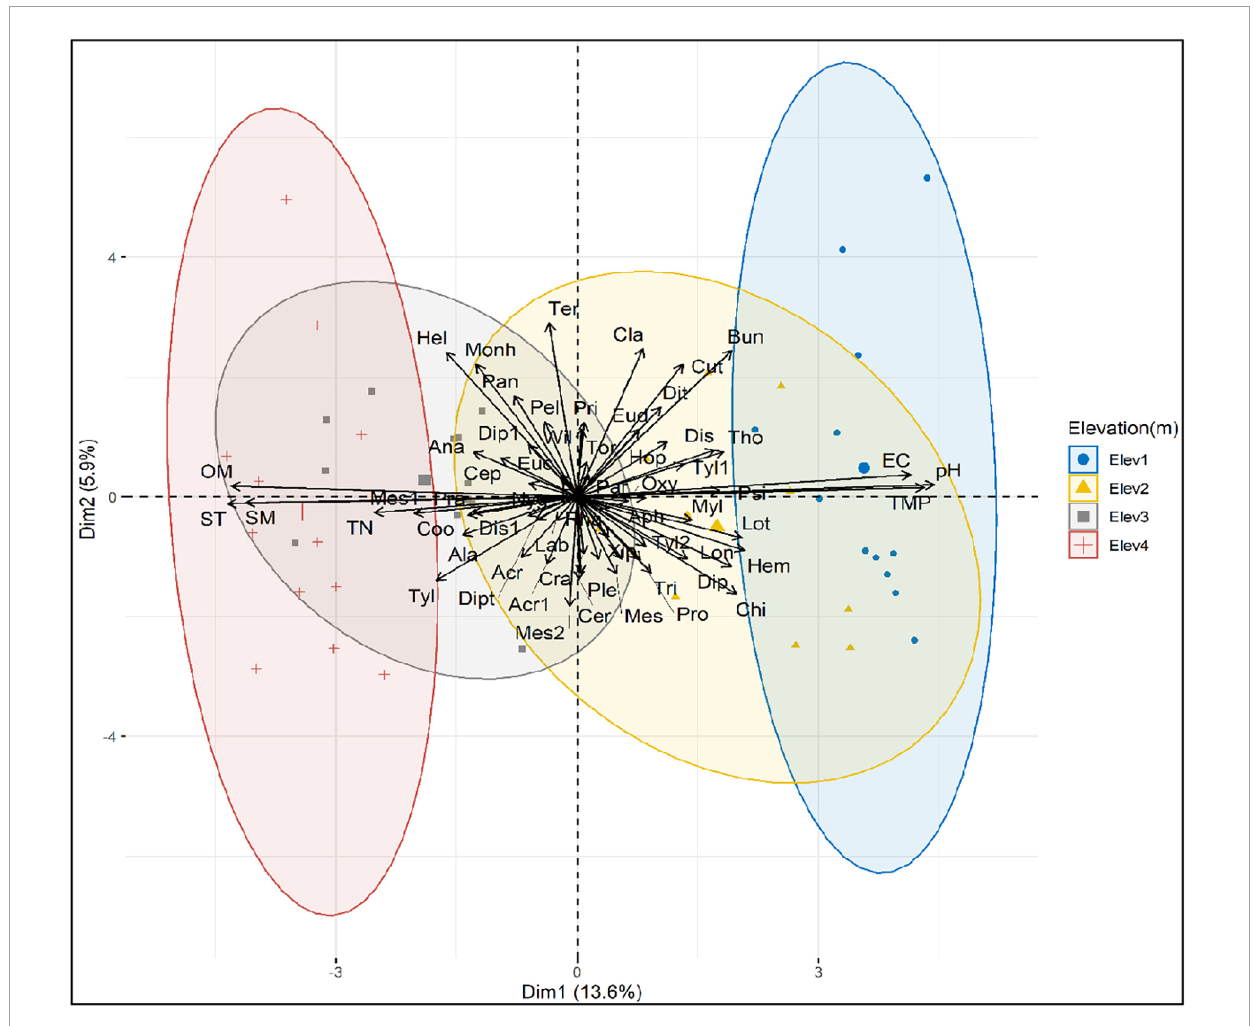
FIGURE6 Principal component analysis (PCA) showing the relationship between soil nematode genera and soil properties across elevation